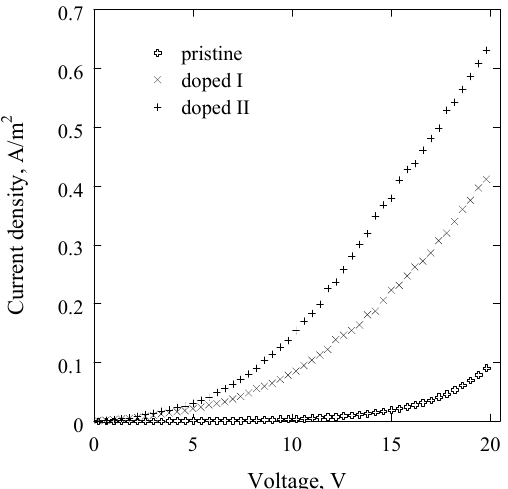
Figure 4. Current density, J , of devices containing pristine and iodine-doped polyterpenol with an applied voltage between 0 V and 20 V.